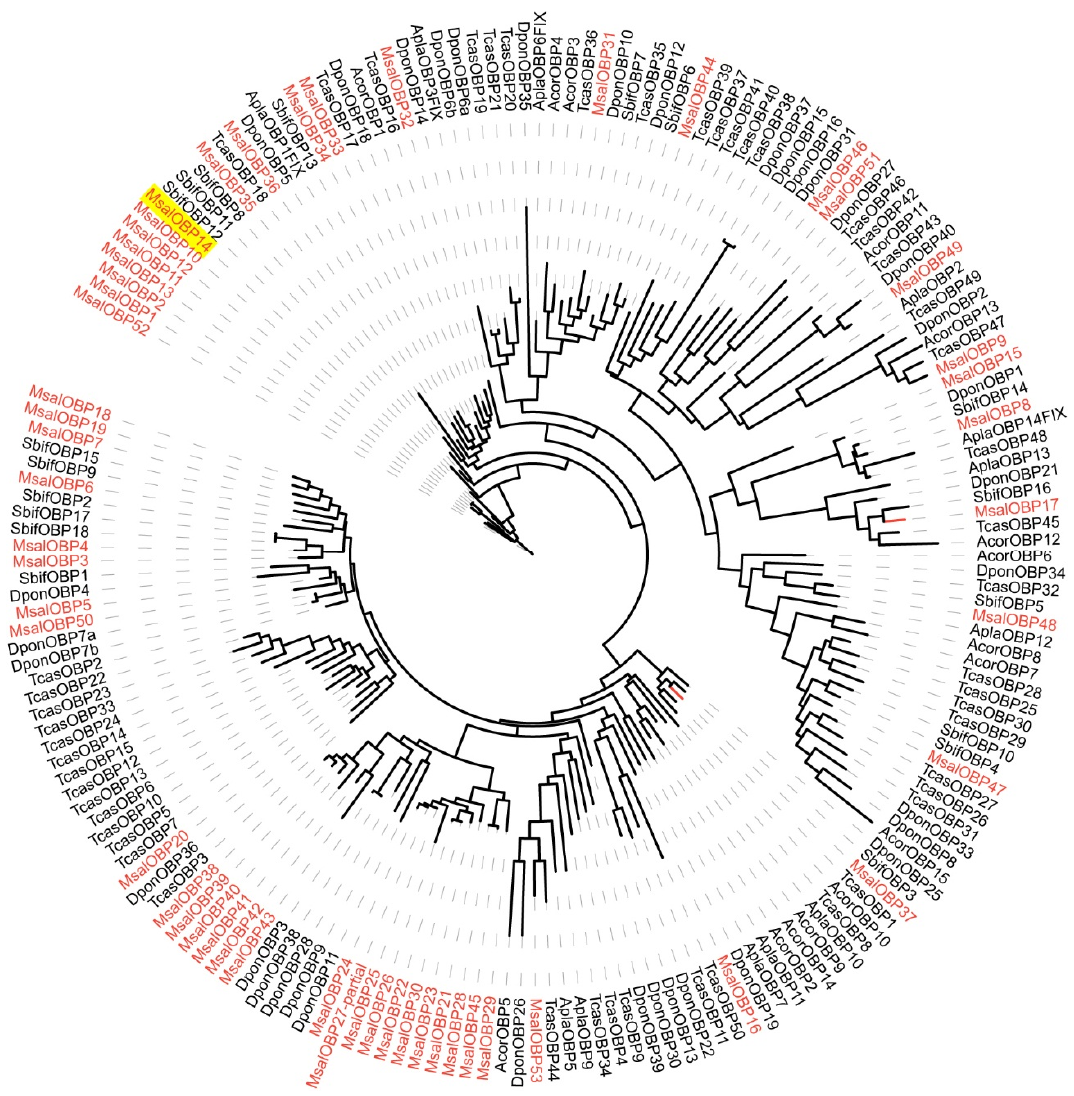
Figure 2. Maximum likelihood dendrogram based on protein sequences of candidate odorant-binding proteins (OBP) in M. saltuarius and orthologs from other Coleopteran insects.JTT + F + R6 model based on the best fit result of IQ-tree model finding, and bootstrap consensus tree inferred from 1000 replicates were used. Monochamus saltuarius (Msal) (red), Semanotus bifasciatus (Sbif), Tribolium castaneum (Tcas), Anomala corpulenta (Acor), Agrilus planipennis (Apla), and Dendroctonus ponderosae (Dpon). MsalOBP14 expressed at an especially high level in male antennae of M. saltuarius was marked with yellow background.